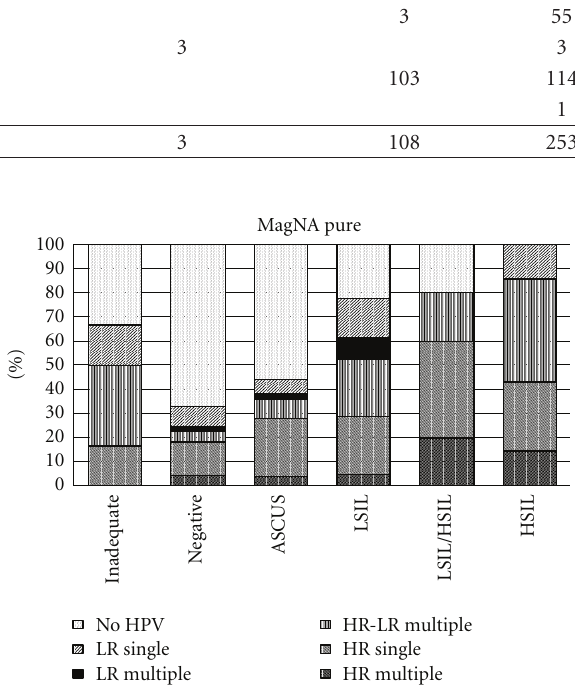
Figure 2: Prevalence of HR-HPV and LR-HPV types according to cytological diagnosis as detected by the MagNA pure extraction